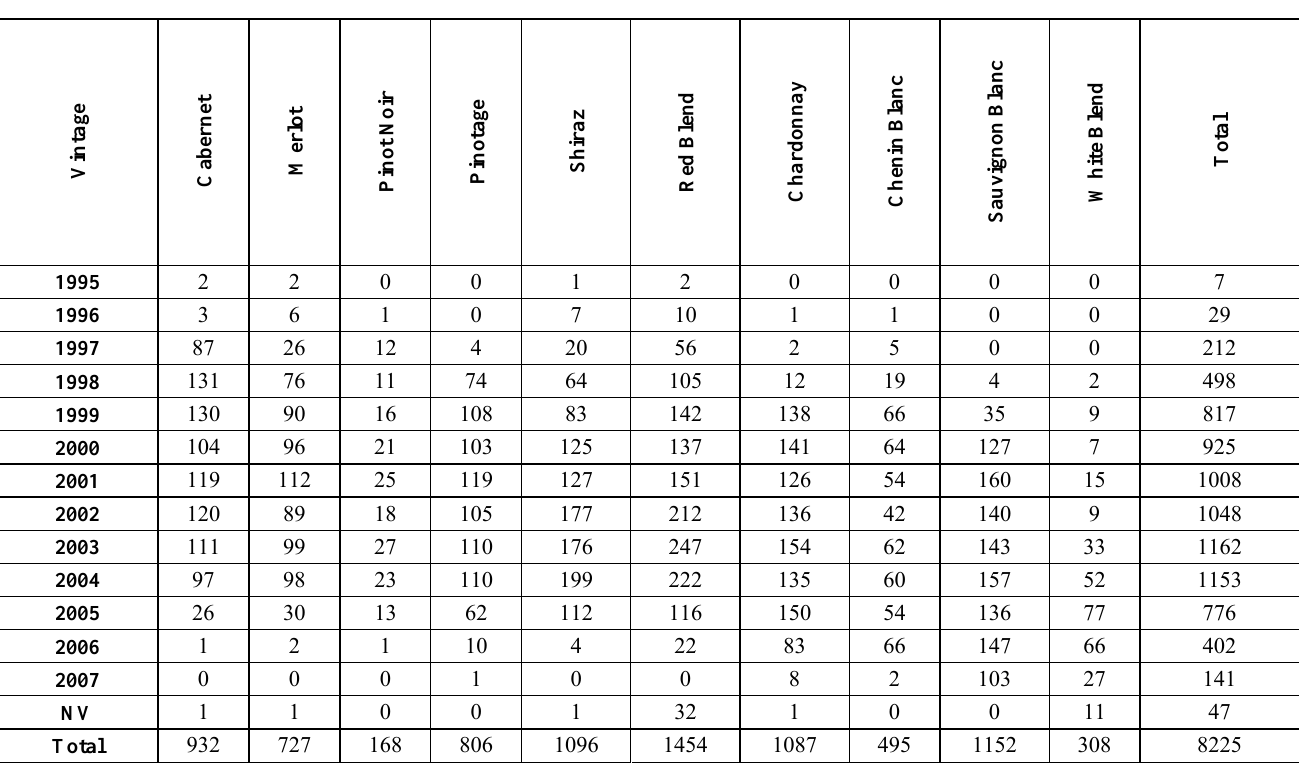
Table 7: The distribution of vintages across the 10 varietals (n = 8225)